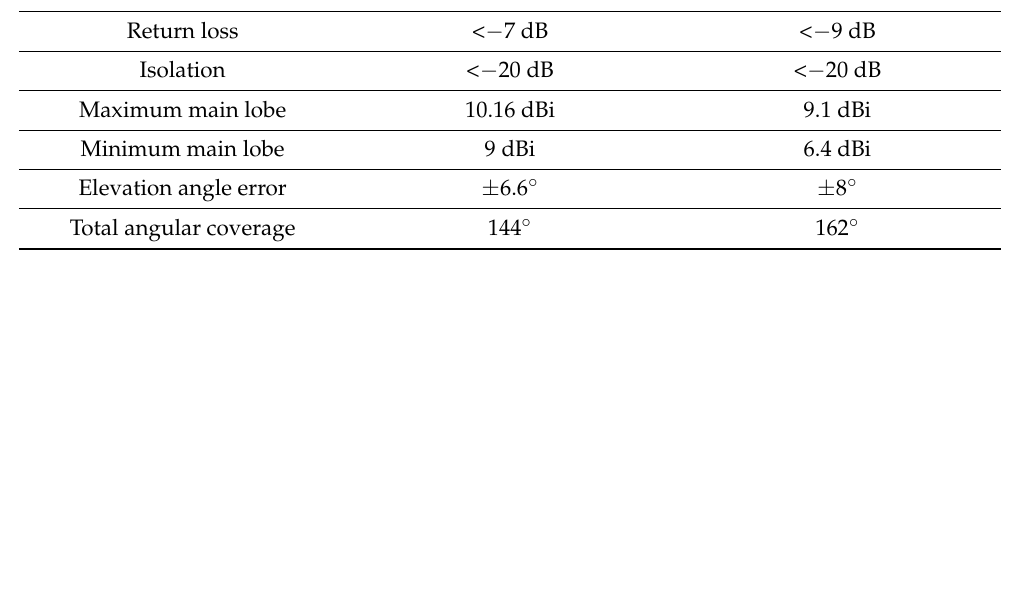
Table 10. Comparison of the performance parameters of the designed 4 × 4 and 8 × 8 Butler matrices.